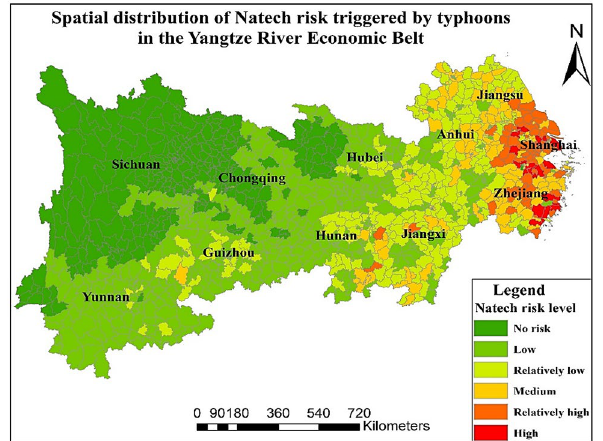
Figure 5. Distribution of Natech risk triggered by typhoons in the YREB. Map is produced using ArcGIS 10.2 (http:// www. esri. com/ softw are/ arcgis/ arcgis- for- deskt